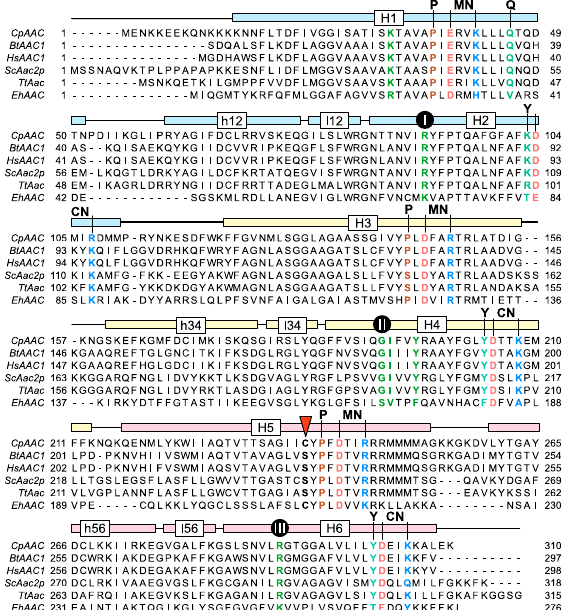
Figure 2. The putative ADP/ATP carrier of C. parvum is homologous to mitochondrial ADP/ATP carriers. Alignment of CpAAC with the mitochondrial ADP/ATP carrier of Bos taurus (BtAAC1), Homo sapiens (HsAAC1), Saccharomyces cerevisiae (ScAac2p), Thermothelomyces thermophila (TtAac), and Entamoeba histolytica (EhAAC). The transmembrane α -helices (H1-6), linker α -helices (l12, l34, l56), and matrix α -helices (h12, h34, h56) are indicated. Repeats 1, 2, and 3 are colored in pastel blue, yellow, and red, respectively. The residues of the Pro-kink (P, brown), matrix network (MN, red and blue), glutamine-brace (Q, cyan), substrate binding site (green), contact points (black circles), tyrosine-brace (Y, cyan), and cytoplasmic network (CN, red and blue) are